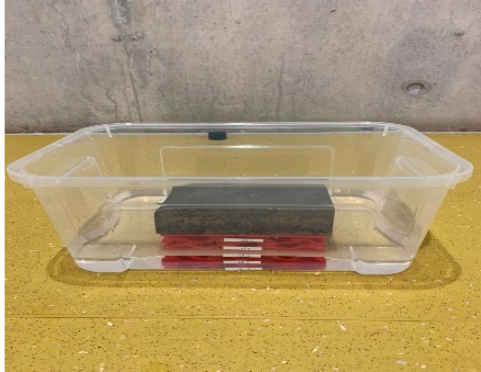
Figure 9. Porous bridge bearing at a fl ood level.